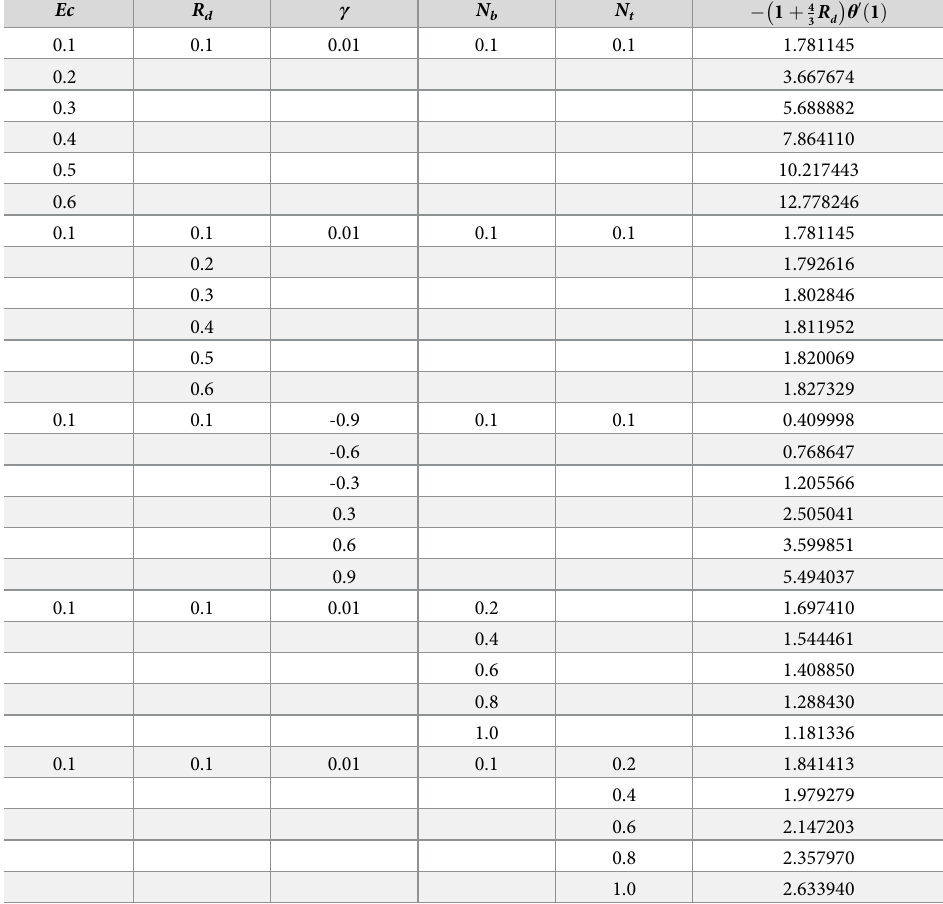
Table 6. Numerical outputs of (cid:0) 1 þ 4 and λ 1 = Pr = Le = R =